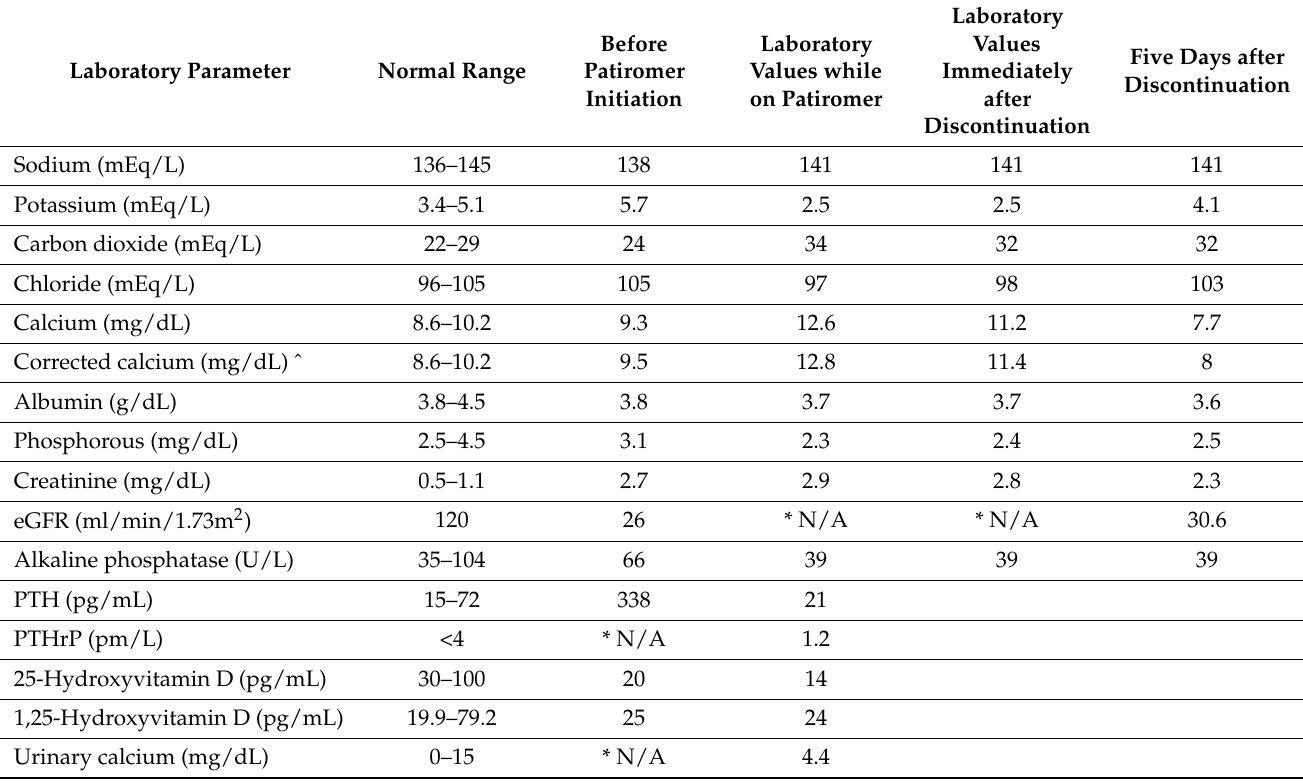
Table 1. Laboratory values of the patient before initiation of patiromer, during and after discontinuation of patiromer.